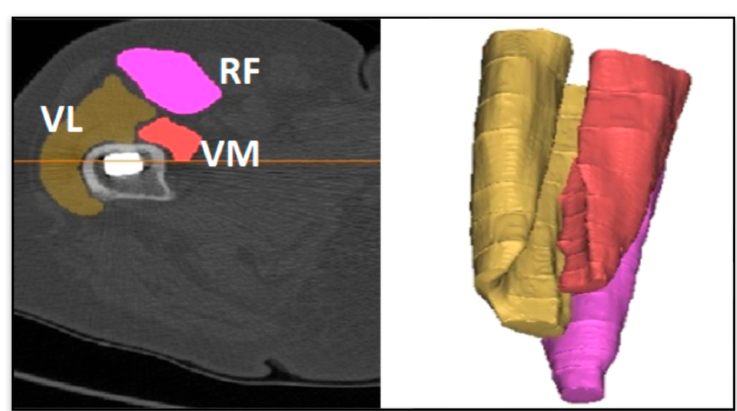
Figure 2. Segmentation of muscles in MIMICS: vastus medialis (VM) in red, vastus lateralis (VL) in gold and rectus femoris (RF only in the figure) in purple.